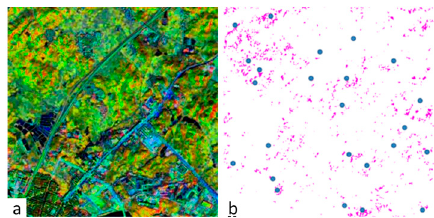
Figure 7. The fusion result based on BEMD (increase using panchromatic images) ( a ) The fusion result based on BEMD and Gram-Schmidt transform, which includes three types of images (panchromatic, multispectral and SAR images). This region located in the northeast of Guilin city, covered 800 × 800 pixels, and the pixel resolution is 4m × 4 m. ( b ) The location of verification points; pink areas represent the area of the extraction of bamboo, blue dots represent verification points.